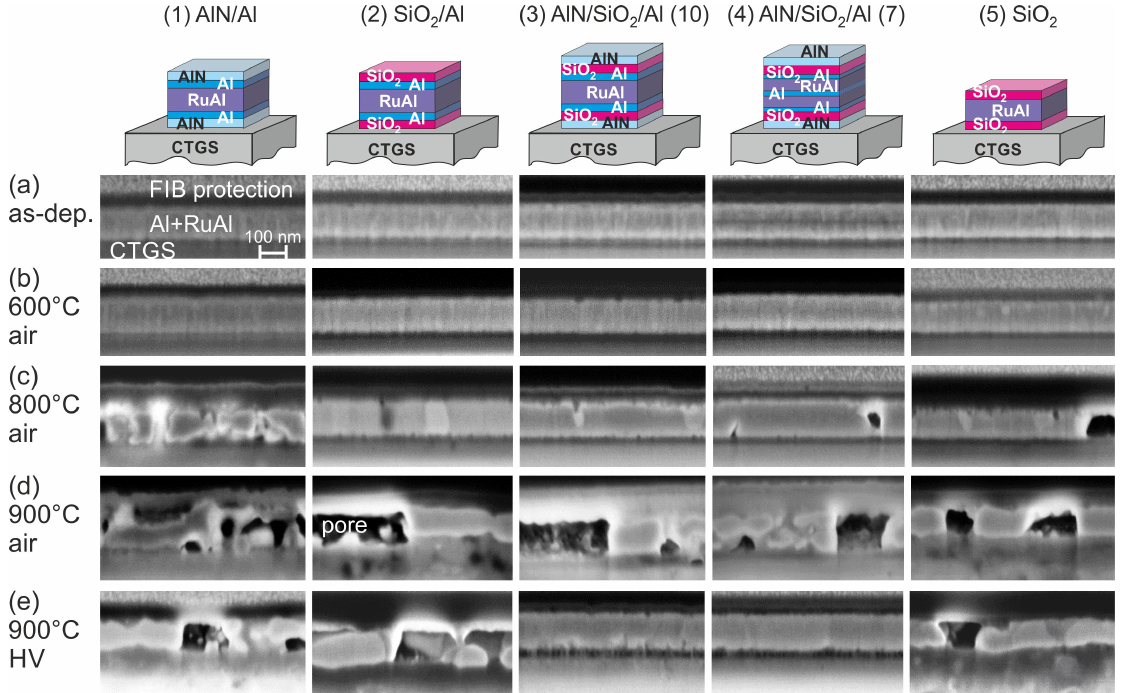
Figure 3. SEM images (inLens, 3 kV) of cross-sections of the RuAl thin films with various protection layers on CTGS in ( a ) the as-deposited state and after annealing in air for 10 h at ( b ) 600 ◦ C, ( c ) 800 ◦ C, ( d ) 900 ◦ C, and ( e ) in high vacuum at 900 ◦